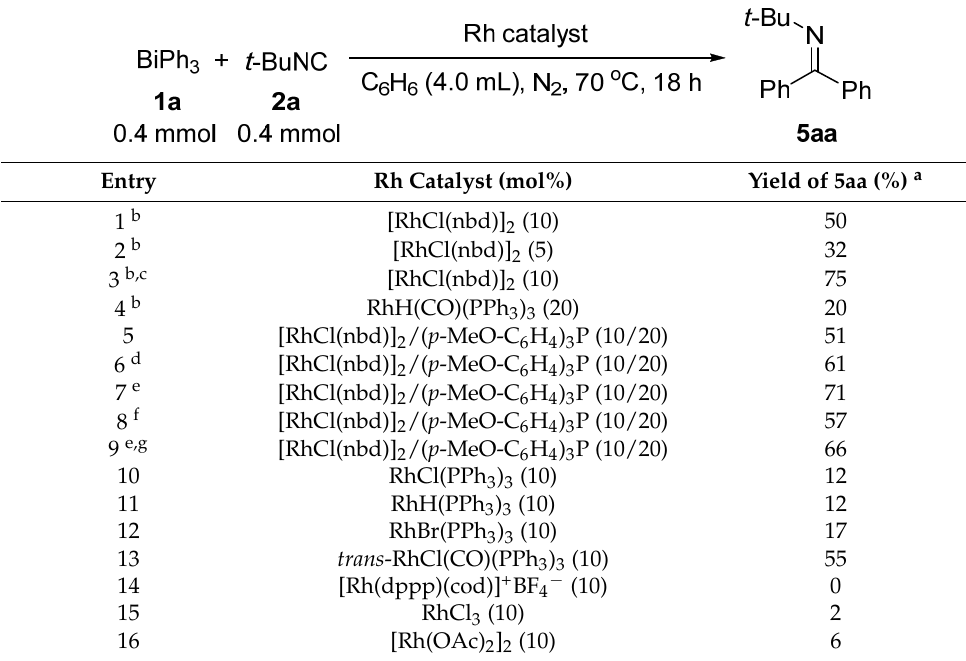
Table 2. Rh-catalyzed diarylation of t -BuNC with BiPh 3 .